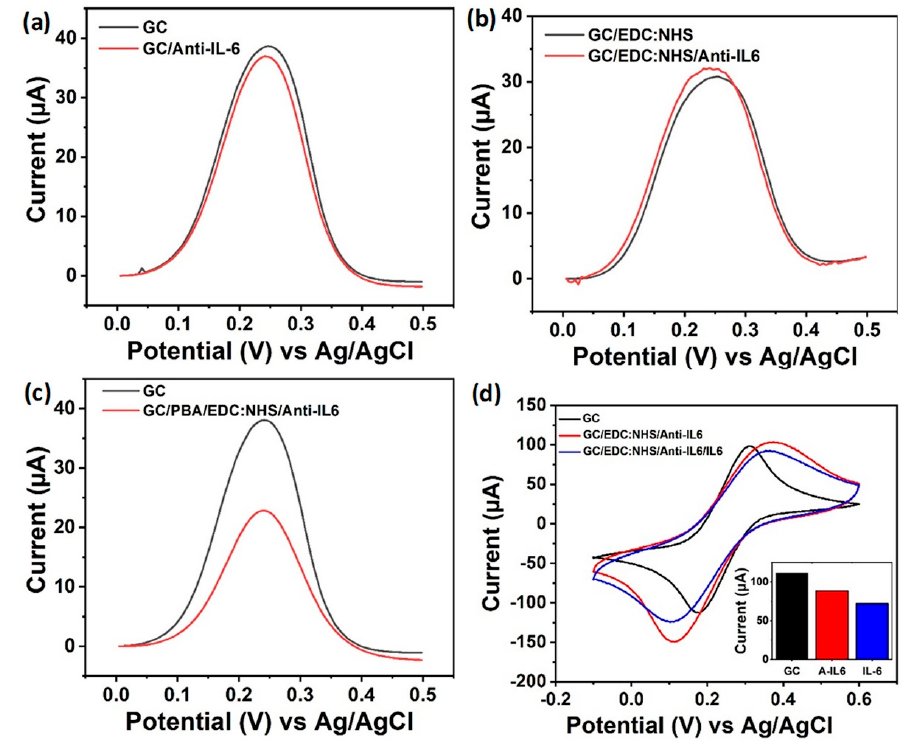
Figure 2. ( a ) Differential pulse voltammetry (DPV) curves of graphitic carbon (GC) electrode before and after attachment of anti-IL-6 antibody; ( b ) GC electrodes modified with EDC:NHS (1-ethyl-3-(3-dimethylaminopropyl) carbodiimide:N- hydroxysuccinimide) before and after anti-IL-6 attachment; ( c ) DPV curves of GC electrode with 1-PBA (1-pyrenebutyric acid) and EDC:NHS modification before and after attachment of anti-IL-6 capture antibody via EDC:NHS coupling; ( d )